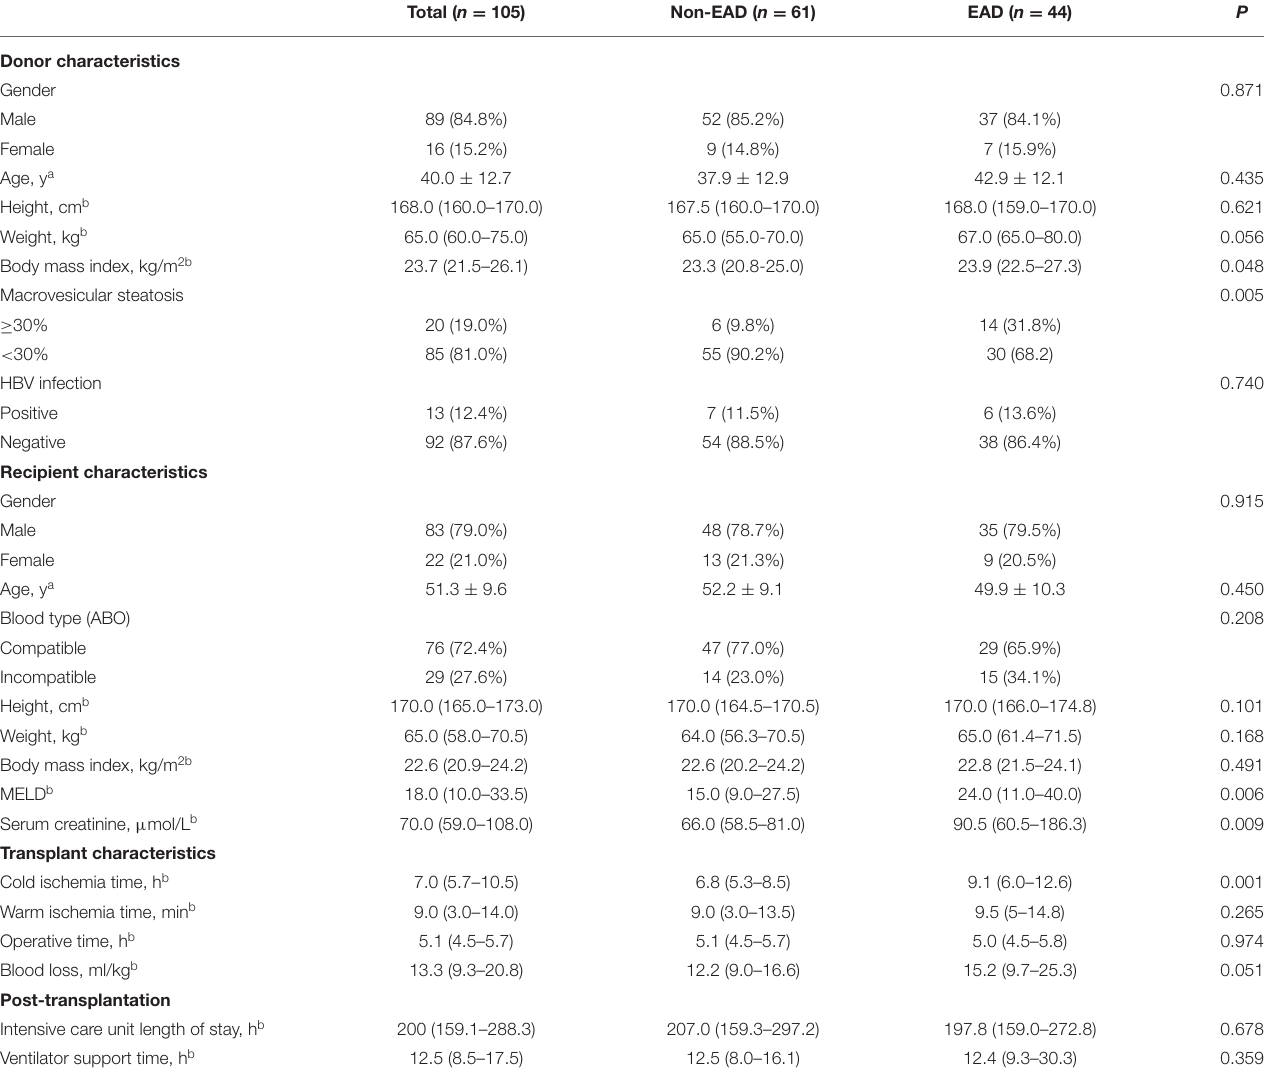
TABLE 1 | Summary of clinical characteristics of the study